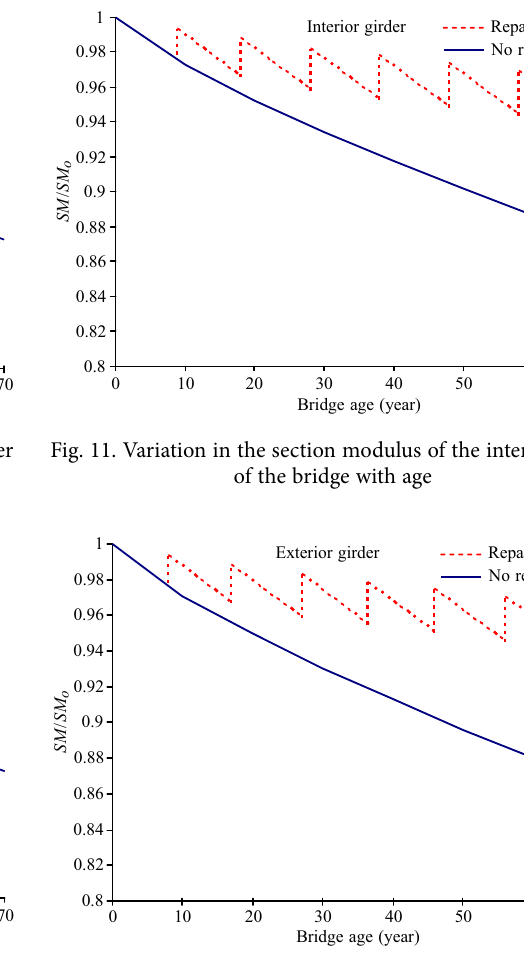
Fig. 10. Variation in the ultimate moment of the exterior girder of the bridge with age